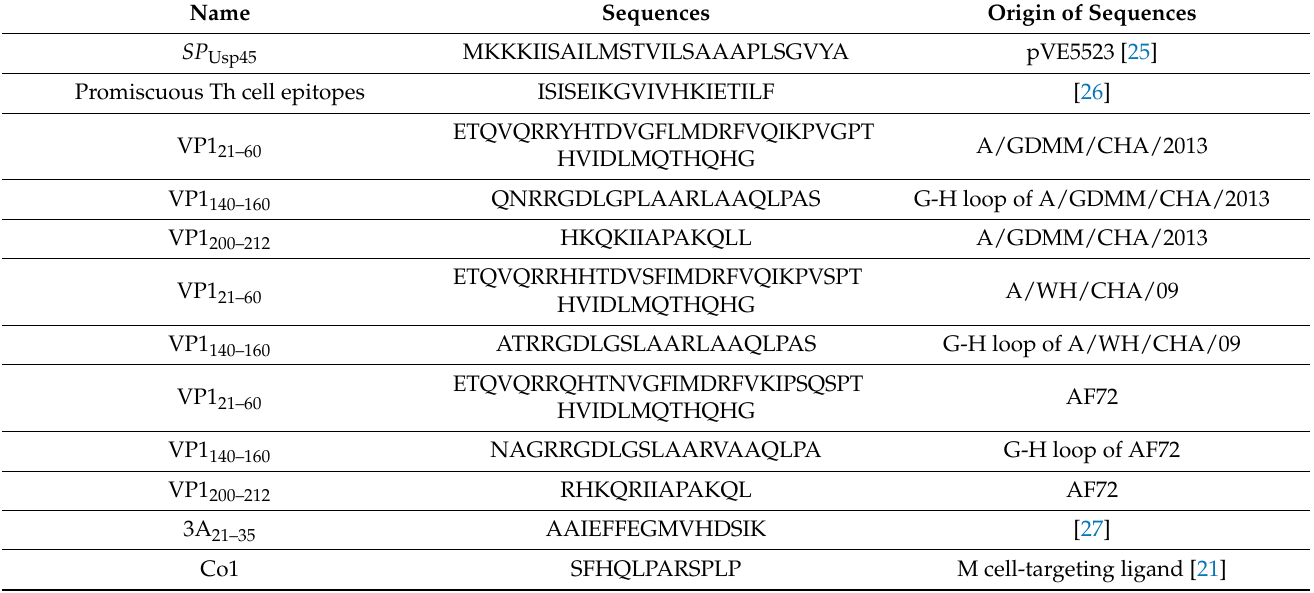
Table 1. G-H loop of the VP1 protein from FMDV serotype A strains and other short